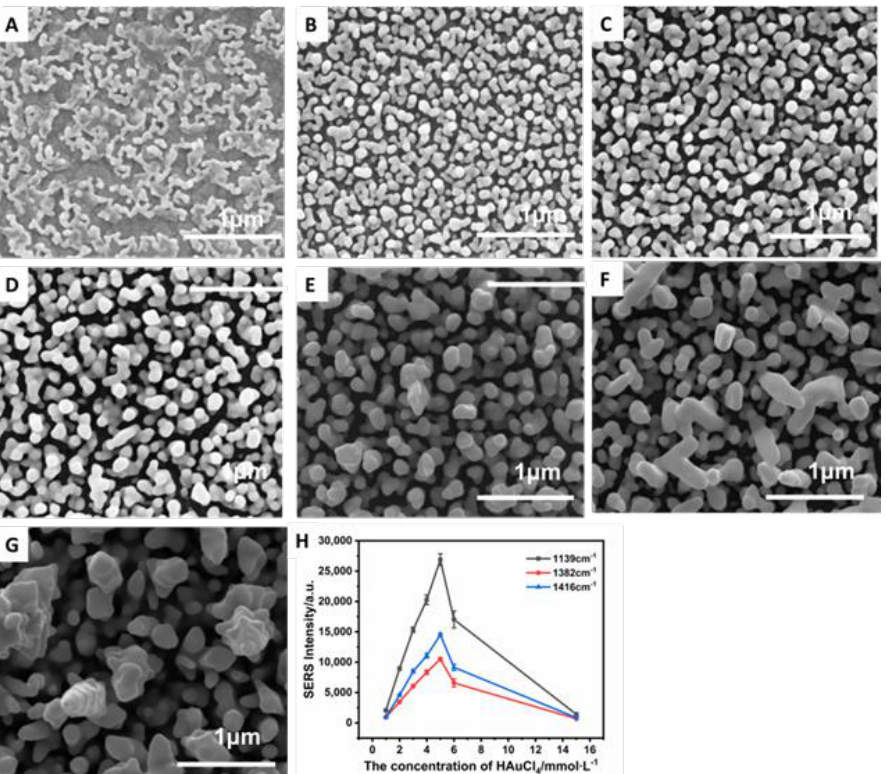
Figure 3. SEM images of AuNPs electrodeposited on the ITO surface using HAuCl 4 in the concentrations of ( A − G ) (1, 2, 3, 4, 5, 6, and 15 mmol L − 1 ) at − 0.6 V deposition potential for 10 min; ( H ) effect of concentrations of HAuCl 4 on the SERS intensity. The error bars were derived from the RSD of five measurements.